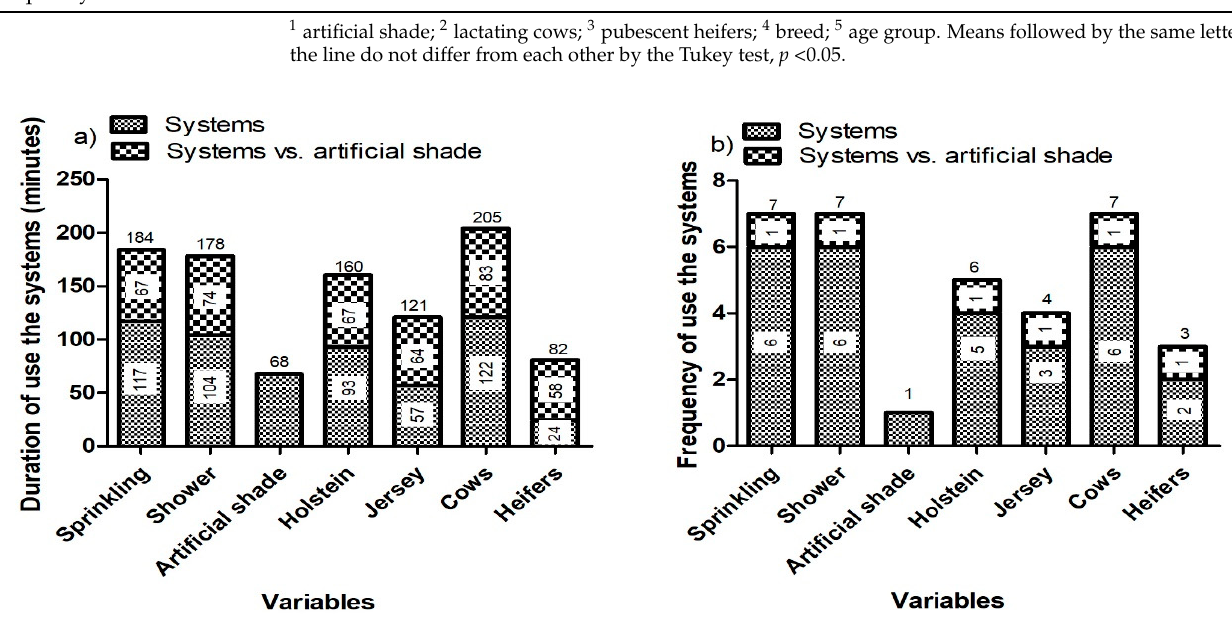
Figure 2. ( a ) Comparison between the structures of the same paddock in relation to duration of use of the systems: sprinkling vs. artificial shading; shower vs. artificial shading; and artificial shading; ( b ) Comparison between the structures of the same paddock in relation to frequency of use of the systems: sprinkling vs. artificial shading; shower vs. artificial shading; and artificial